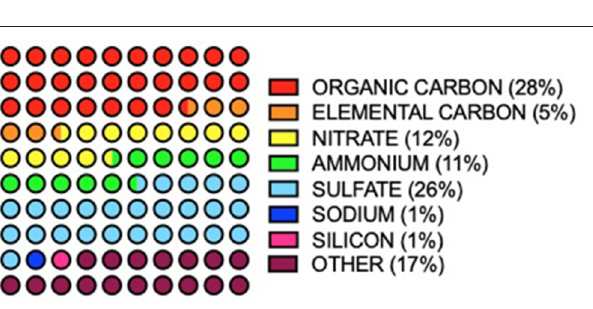
FIGURE 2 | Annual averages of major PM2.5 components ( > 1 total mass%) in 187 USA counties between 2000 and 2005. Values from